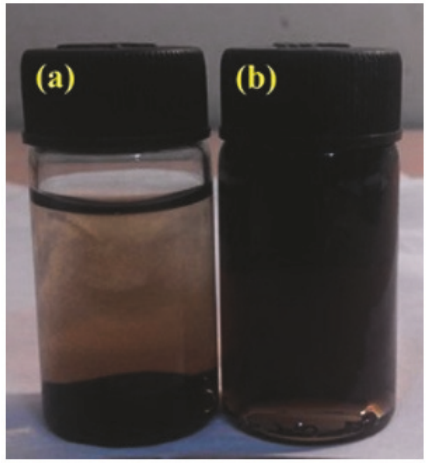
Figure 2: (a) Unstable suspension of [GO − /Zn 2+ ] 𝛿+ nanoclusters (zeta potential = 11.8mV); (b) CTAB-stabilized suspension of [GO − /Zn 2+ ] 𝛿+ nanoclusters (zeta potential = 46.3